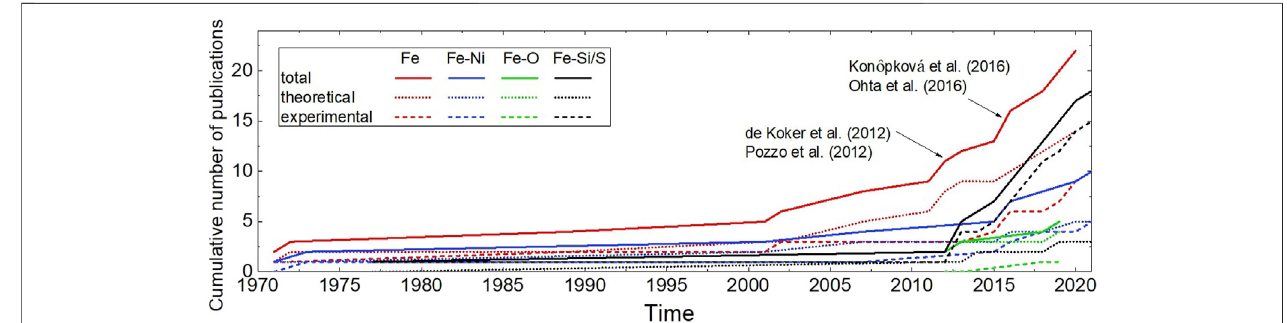
FIGURE 1 | Cumulative number of publications on theoretical and experimental methods of estimating ρ of Fe, Fe-Ni, Fe-O and Fe-Si and S alloys at the core conditions of Earth, Moon, Mercury, Mars, and Ganymede.